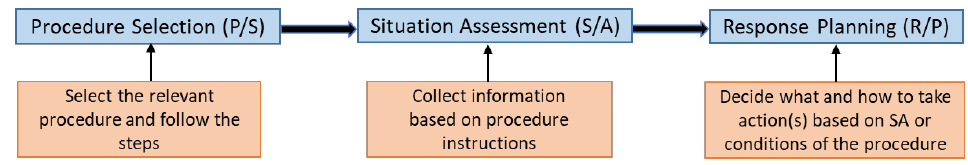
Figure 4. The sequence of diagnosis tasks in emergency operations.